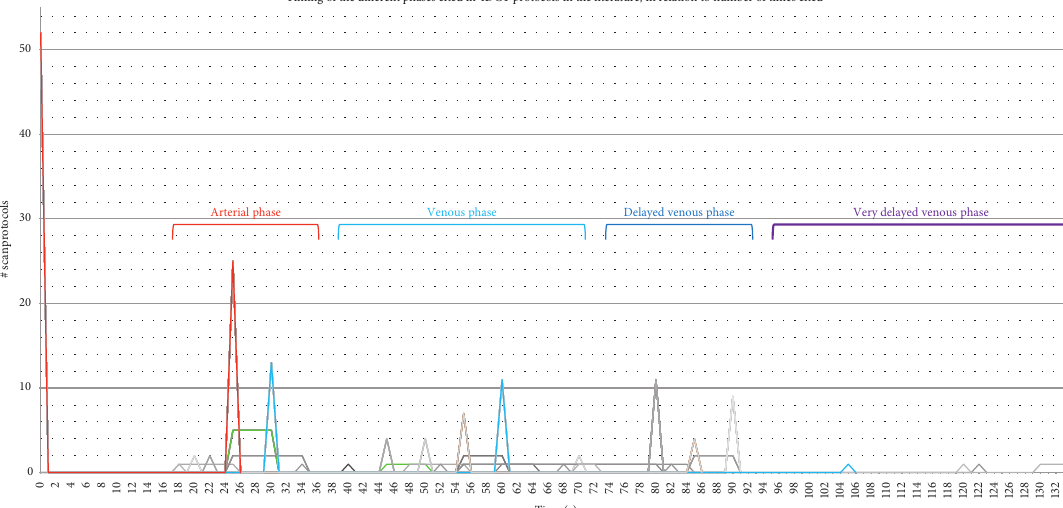
Figure 2: Timing of the different phases of 4DCTprotocols in the literature, in relation to the number of citations for each of these relevant time